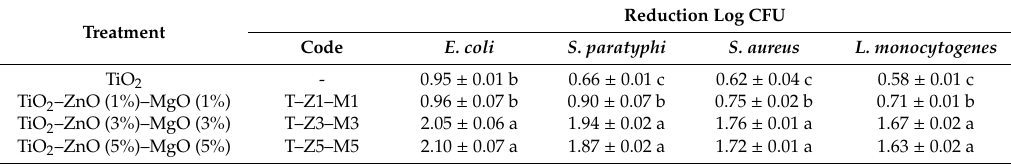
Table 1. Lethal e ff ect of TiO 2 and mixed oxide nanomaterials on pathogenic bacteria.